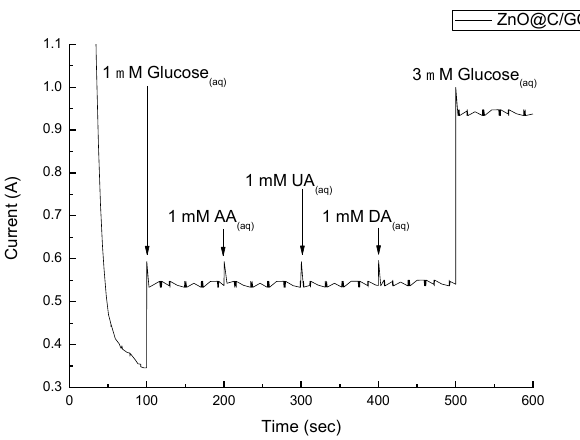
Figure 11. Amperometric response of ZnO@C/GC electrode to 1.0 µM glucose, as well as 1 mM interferents of citric acid (CA), uric acid (UA), and dopamine (DA).